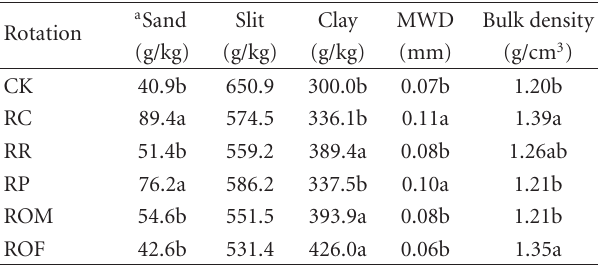
Table 3: Soil physical properties in 0–20 cm depth.